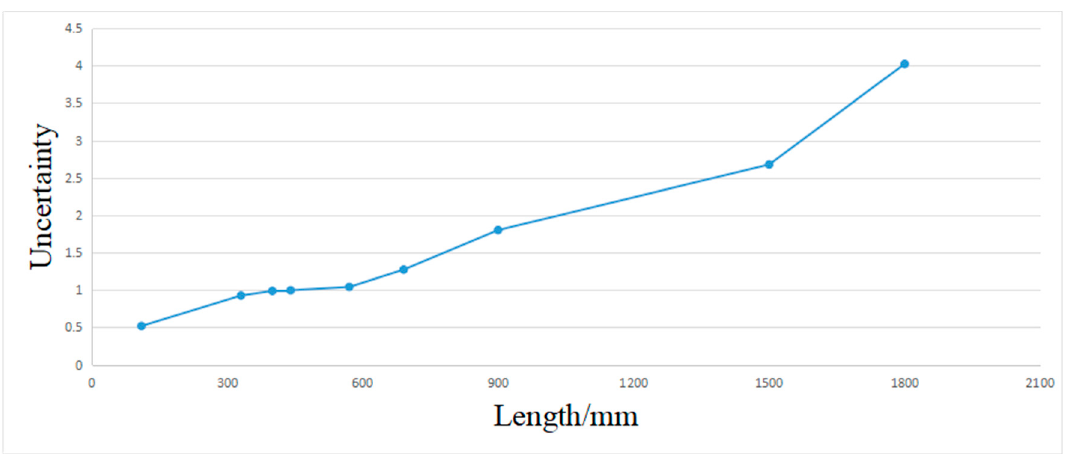
Figure 22. The relationship between the measurement uncertainty and the box length.